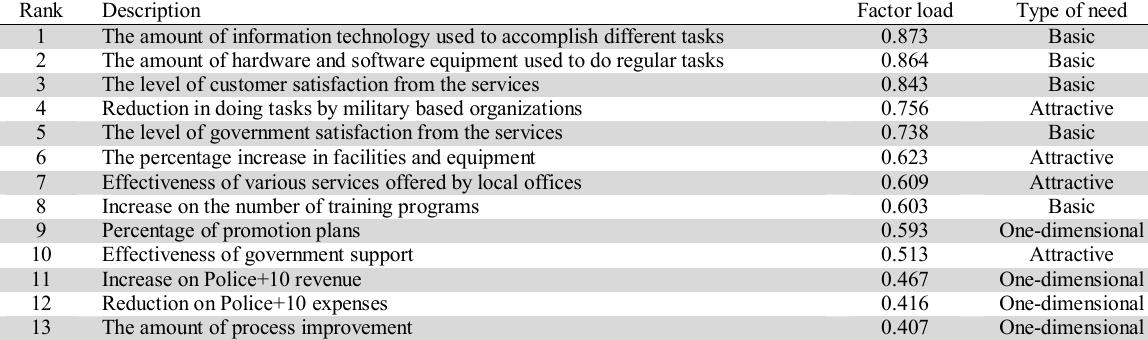
The summary of ranking different